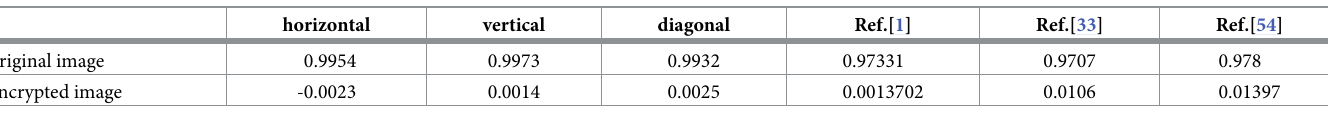
Table 15. Ordinary image correlation coefficient comparison table.